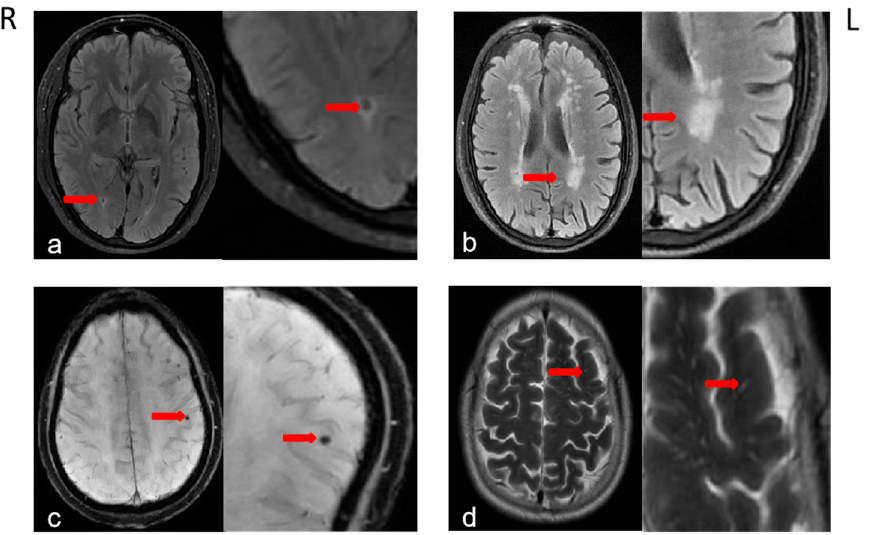
Figure 1. Characteristics of four CSVD-related imaging findings. The red arrow points to the location where the CSVD-related feature was examined. CSVD, cerebral small vessel disease. ( a ) SLI, silent lacunar infarction; ( b ) WMH, white matter hyperintensities; ( c ) CMB, cerebral microbleeds; ( d ) EPVS, enlarged perivascular spaces.